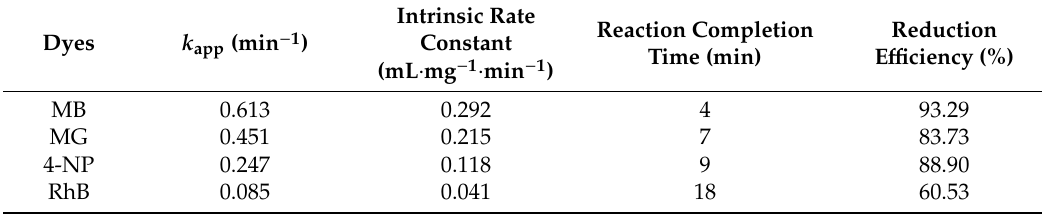
Table 3. Reduction of various dyes in the presence of CAg-nPs using NaBH 4 as reducing agent.